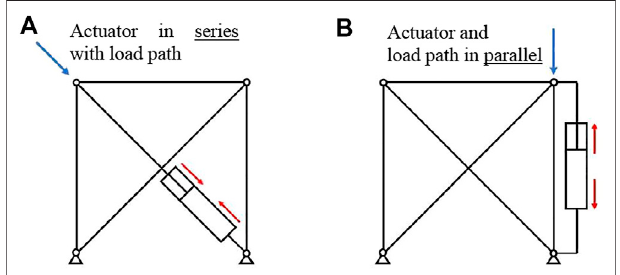
FIGURE 6 | Visualization (left) and realization (right) of the column-integrated actuator (Source: IKTD).